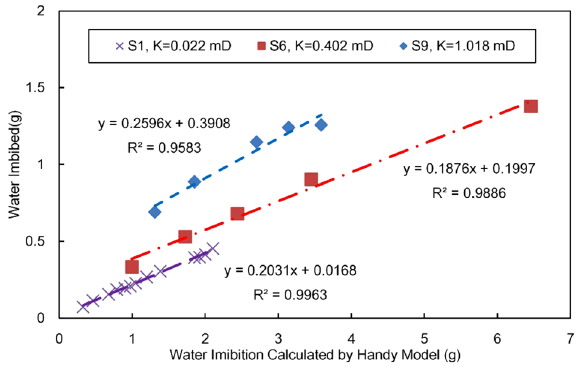
Figure 10. Experimental water imbibition versus the calculated value of Handy